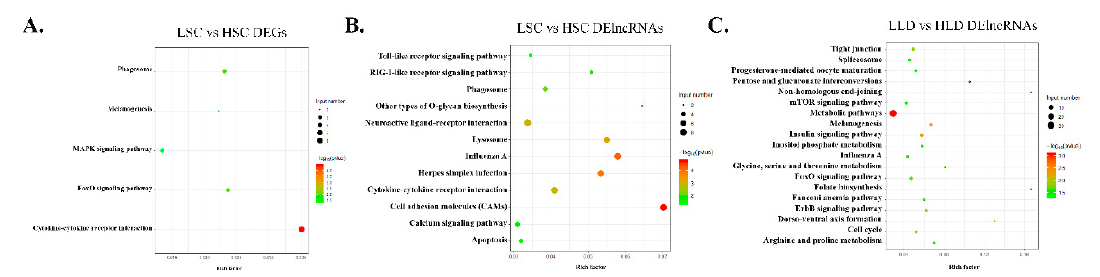
Figure 5. Functional analysis of the DEGs and DE lncRNAs in intra-breed groups with different egg production performances. KEGG pathways significantly enriched by the DEGs ( A ) and the DE lncRNAs ( B ) in the LSC vs. HSC group and the DE lncRNAs ( C ) in the LLD vs. HLD group.